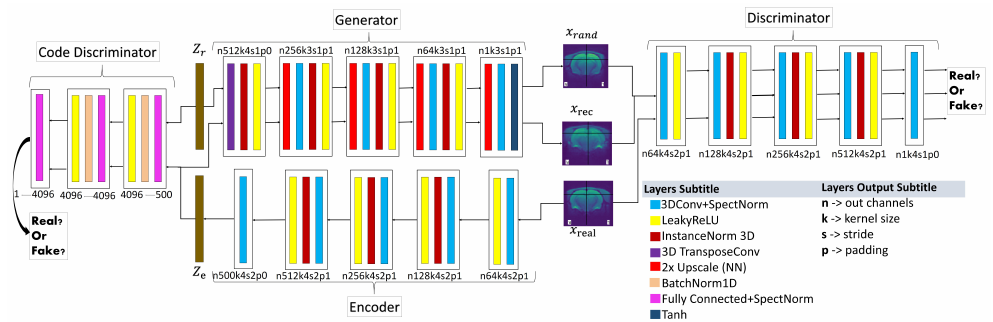
Figure 5. α -WGANSigmaRat1 architecture. Near each layer, there is a code that explains the result of each convolution, e.g., n256k3s1p1: n256, size of the output channels (in this case 256); k3, kernel size (cubic dimension 3 × 3 × 3); s1, stride (1 × 1 × 1); p1, padding (1 × 1 × 1). Please use the virtual version to get a more detailed visualisation.